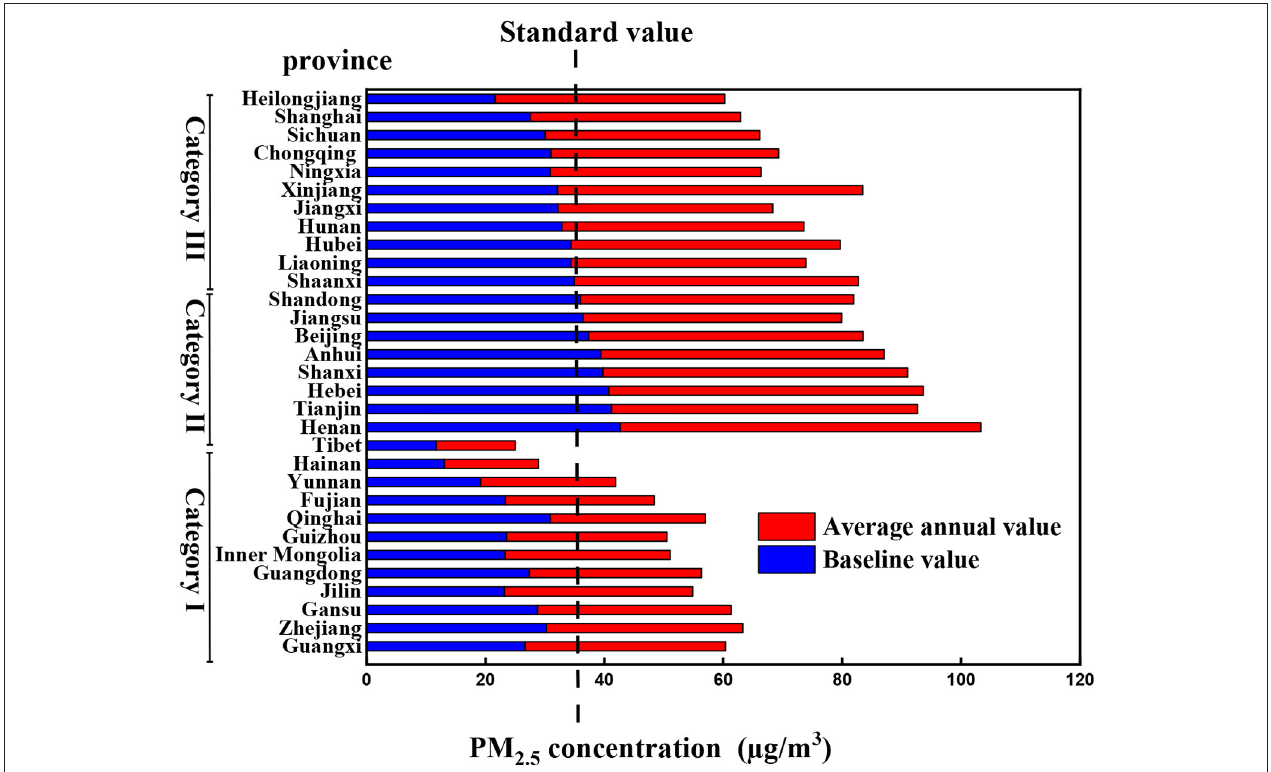
FIGURE 2 | Classification diagram based on the relationship between baseline value, monitoring value, and standard value in 31 provinces.